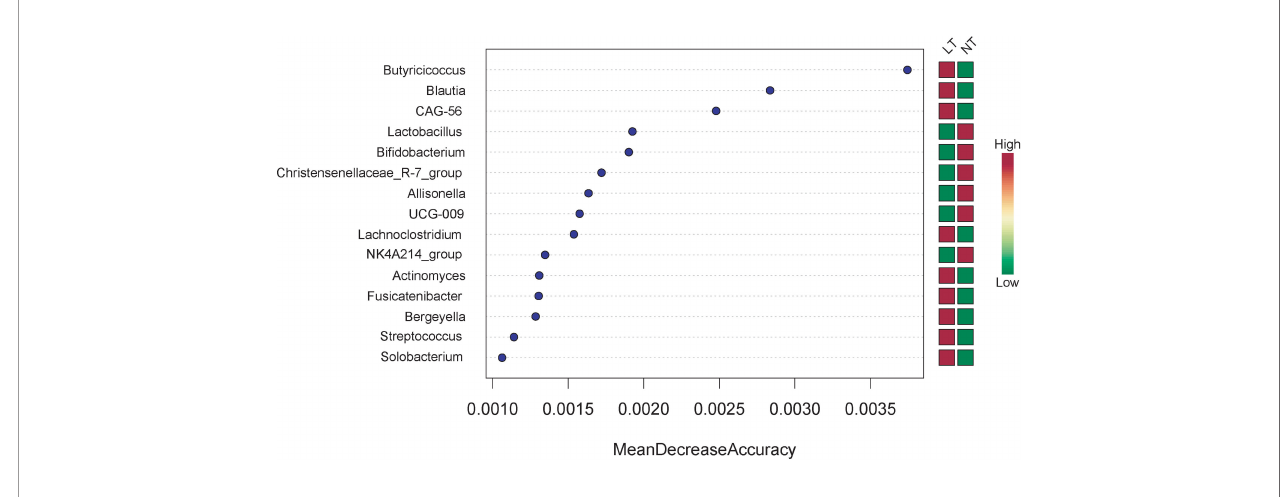
FIGURE 4 | Comparison of Random Forest Model based on taxa composition.